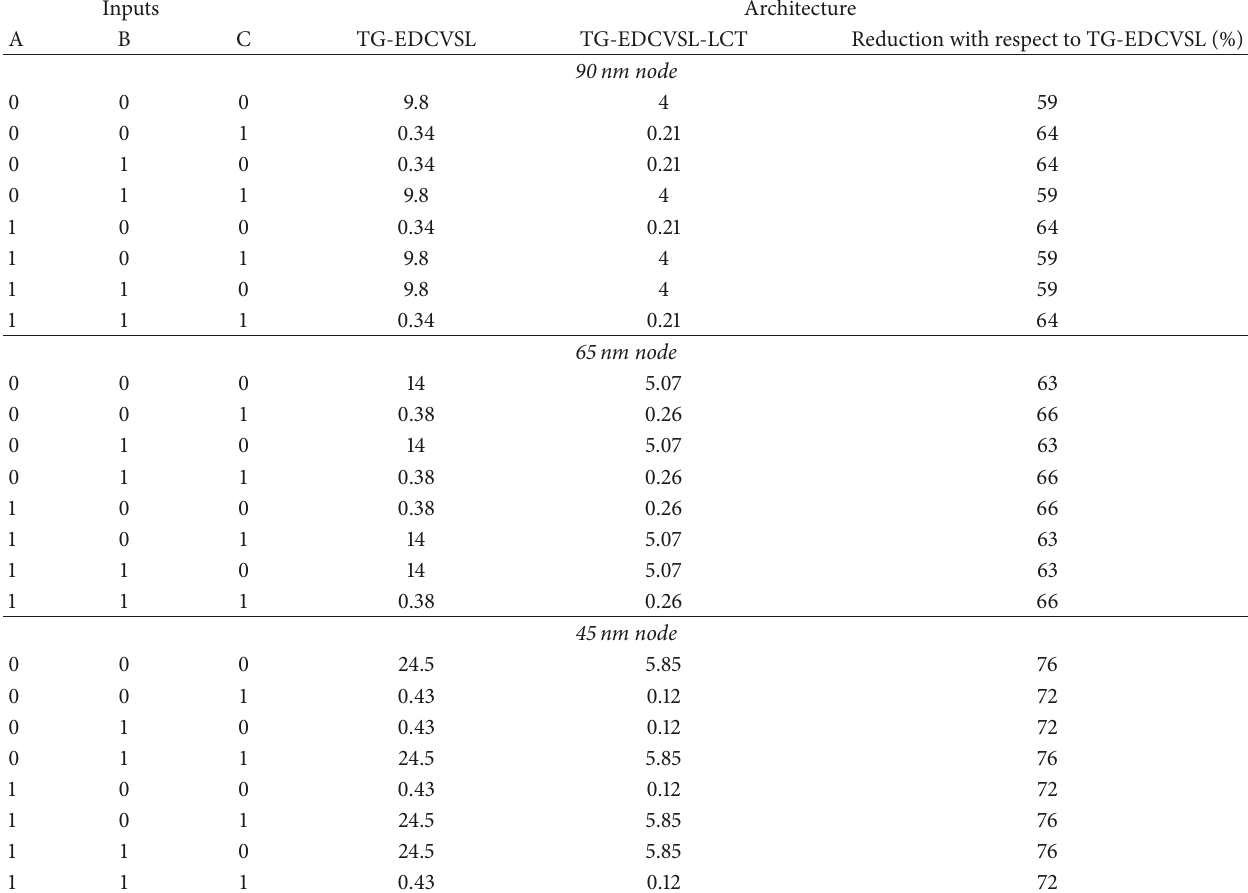
Table 4: Leakage power (nW) in TG-EDCVSL and TG-EDCVSL-LCT three-input XOR-XNOR gates.